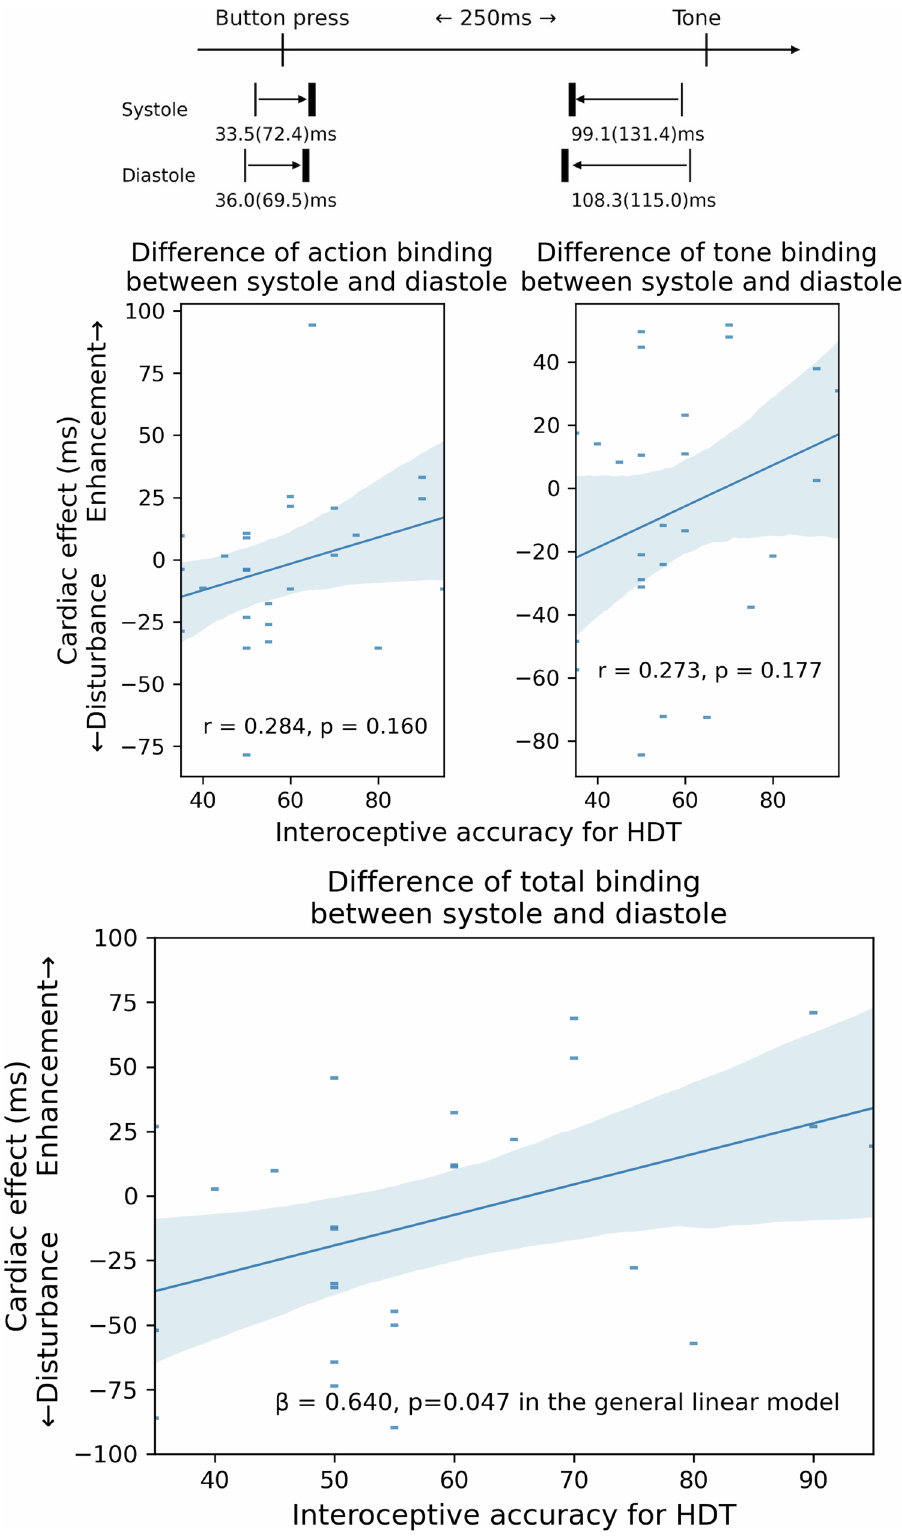
Figure 2. Cardiac effect can enhance or disturb total binding effects depending on interoceptive accuracy for HDT (β = 0.640, p =